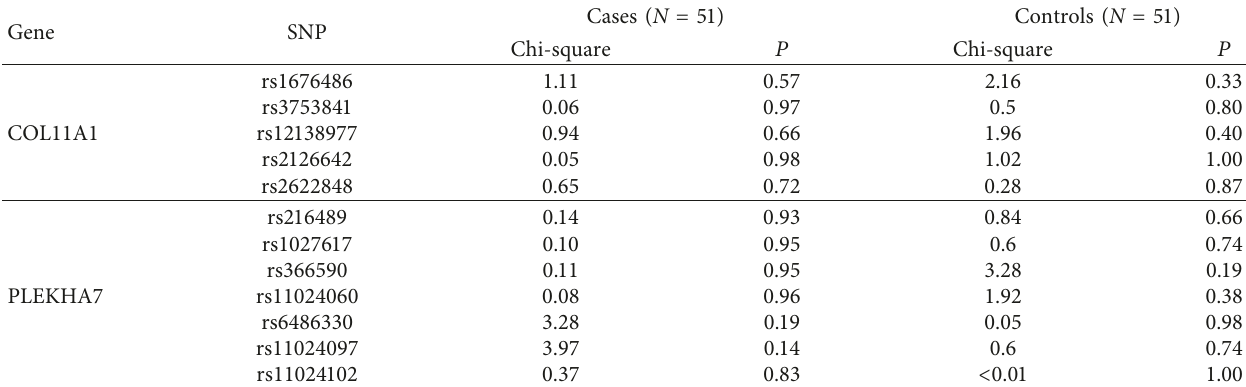
Table 2: Hardy–Weinberg equilibrium.